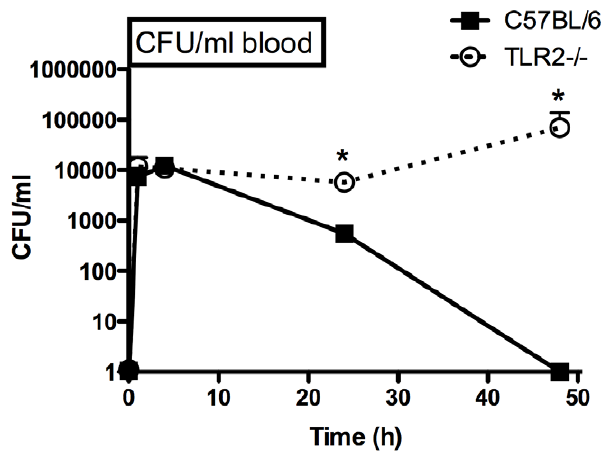
Figure 6. TLR2-deficient mice demonstrate impaired clearance of SE bacteremia. Female C57BL/6 WT or TLR2-deficient mice were injected i.v. with 10 8 CFU of SE prior to collection of peripheral blood at 1, 4, 24 or 48 h for measurement of CFUs by plating serial dilutions (n=4–9); *p , 0.05.